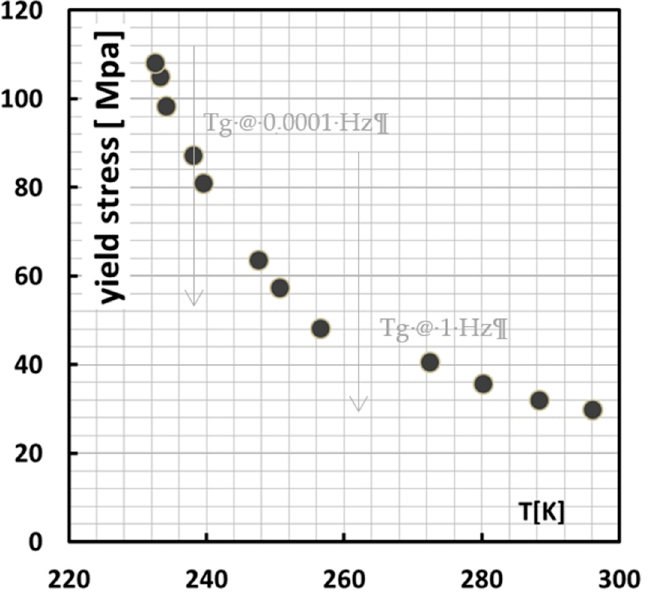
Figure 11. T dependence of yield stress at a strain rate of 0.0001 Hz around T g as calculated from the data in Figure 3, assuming a t,T equivalence of 7.8 K/decade. The arrows indicate T g at 1 Hz, and at 0.0001 Hz.